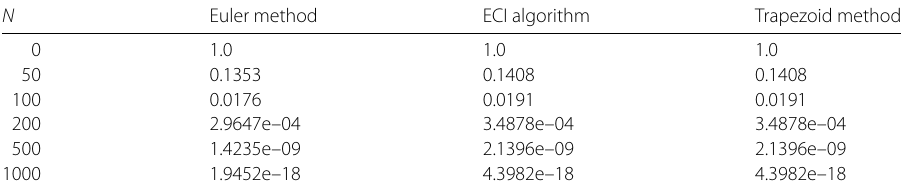
Table 1 Comparison of numerical solutions for different number of steps, N , obtained by different methods N Euler method